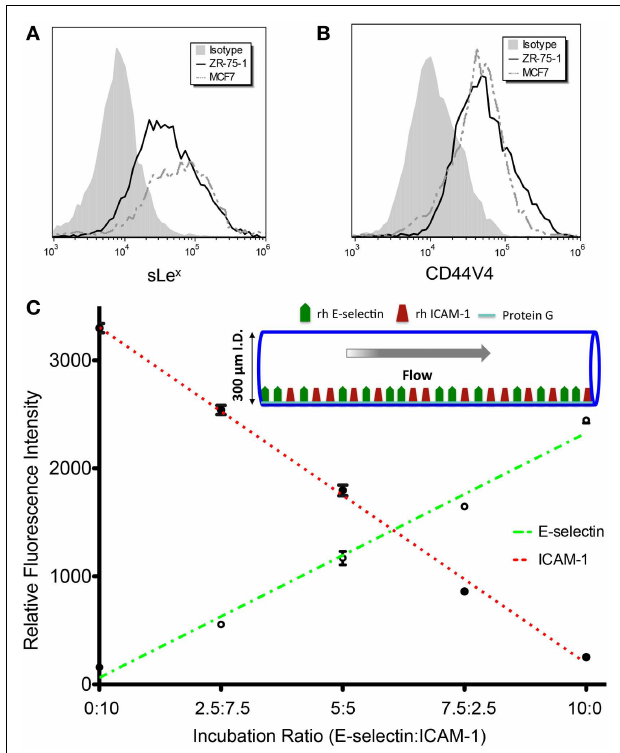
FIGURE 2 | (A,B) Flow cytometry histogram overlays of ZR-75-1 and MCF7 cells labeled with anti-sLe x (clone CSLEX) mAb and anti-CD44V4 mAb, respectively. (C) E-selectin and ICAM-1 fluorescence intensities as concentration ratios vary during surface preparation.The r 2 values for E-selectin and ICAM-1 fluorescence intensity trend lines were found to be 0.986 and 0.995, respectively.